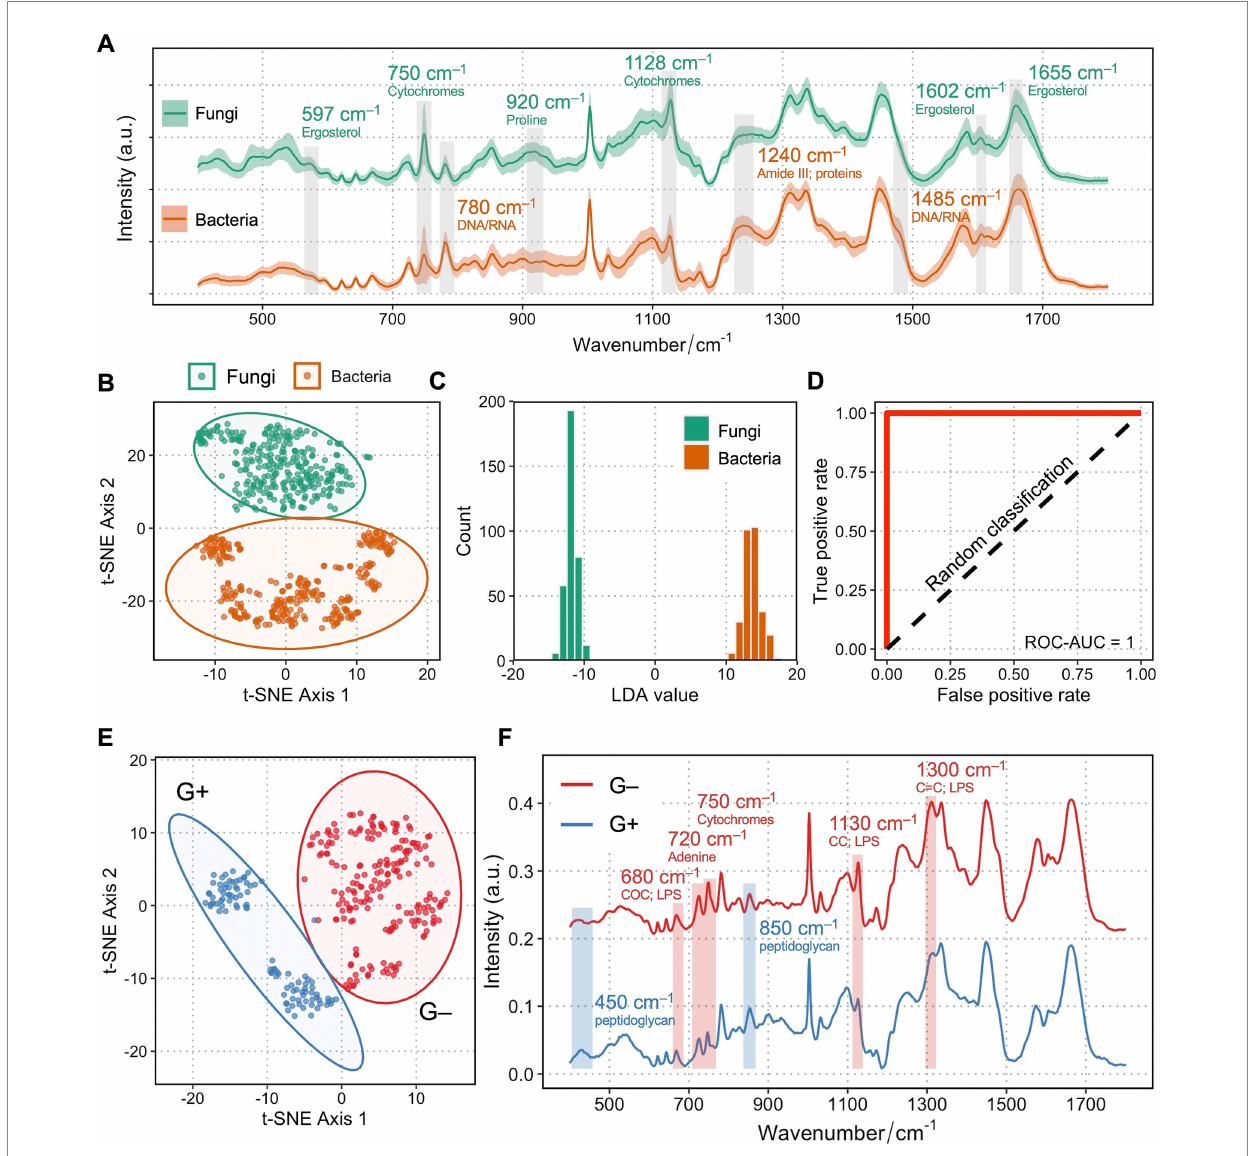
FIGURE 1 Raman spectra of fungi and bacteria clearly differentiate between each other. (A) Averaged Raman spectra of 35 clinical isolates from 7 fungal species ( n = 350) and 30 clinical isolates from 6 bacterial species ( n = 300). Shaded area represents standard deviation from single-cell measurements. Biological assignments of Raman bands contributing mostly to the differentiation between bacteria and fungi are highlighted with either a higher band intensity in fungi (labeled as green) or in bacteria (labeled as tawny). (B) Unsupervised t-SNE visualization of fungi and bacteria based on their single-cell Raman spectra show two distinct clusters. (C) Histogram of LDA values of an LDA binary classification model. (D) ROC of the LDA model showing a ROC-AUC of 1. (E) Unsupervised t-SNE visualization of Gram-positive (blue) and Gram-negative (red) bacteria based on their single-cell Raman spectra show two distinct clusters. (F) Raman spectra of Gram-positive (blue) and Gram-negative (red) clearly differentiate between each other. Shaded area represents standard deviation from single-cell measurements. Biological assignments of Raman bands contributing mostly to the differentiation between two groups are highlighted with either a higher band intensity in Gram-positive (labeled as blue) or in Gram-negative bacteria (labeled as